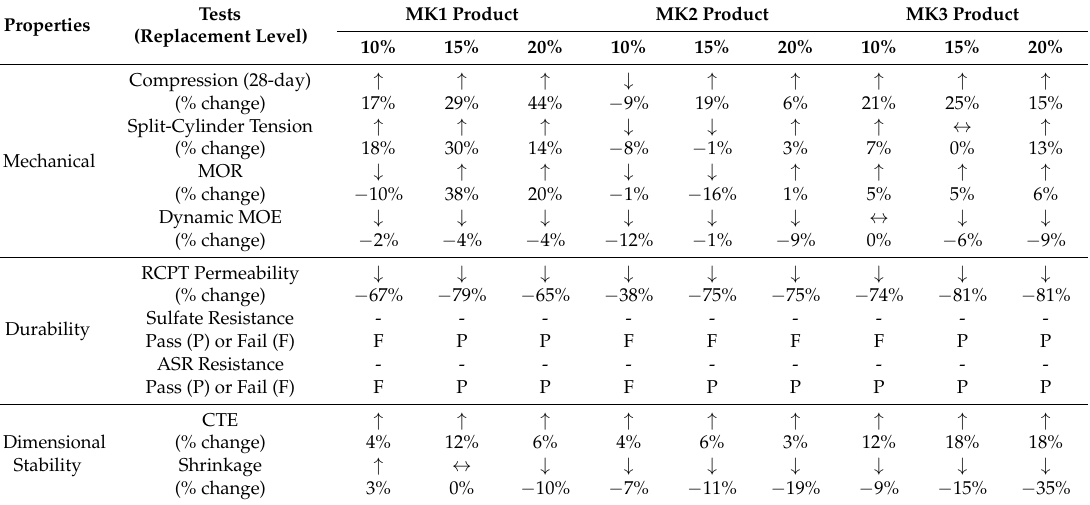
Table 6. Summary of test results for all mixtures compared to the control